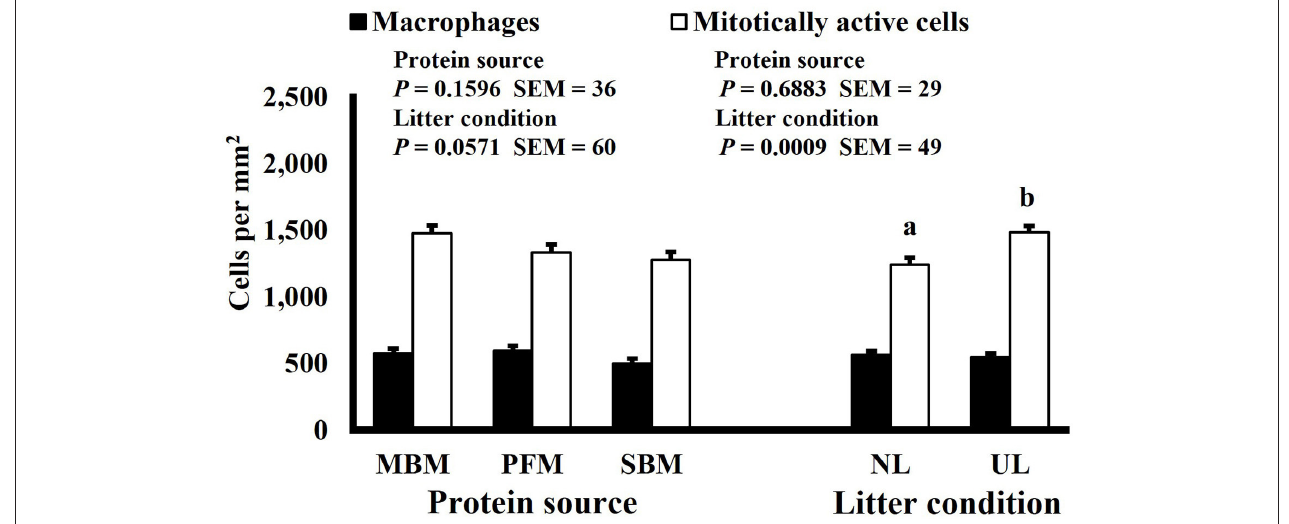
FIGURE 4 | Effect of dietary protein source and litter condition on macrophage (KUL01 + ) and mitotically active (BrdU + ) cell densities (cells per mm 2 ) in the duodenum of 11-d-old broilers ( n = 36 per sampling d, 6 birds per treatment). MBM, meat and bone meal; PFM, 50% poultry by-product and 50% feather meal blend; SBM, soybean meal; NL, new litter; UL, used litter.